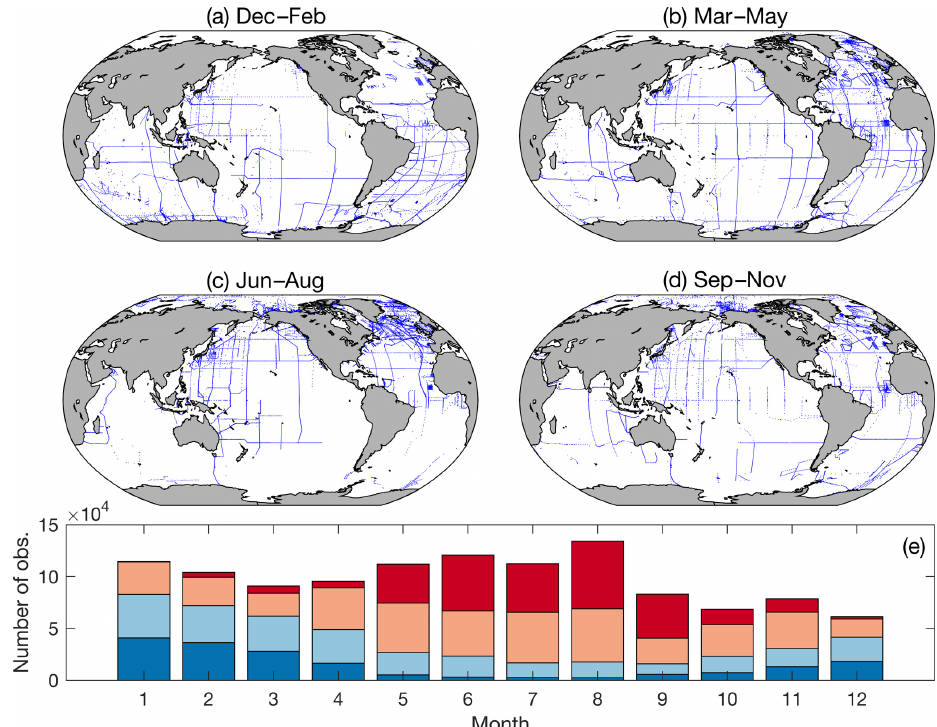
Figure 7. Distribution of data in GLODAPv2.2019 in (a) December–February, (b) March–May, (c) June–August, and (d) September– November and (e) number of observations for each month north of 45 ◦ N (red), north of the Equator to 45 ◦ N (orange), the Equator to 45 ◦ S (light blue), and south of 45 ◦ S (dark blue).